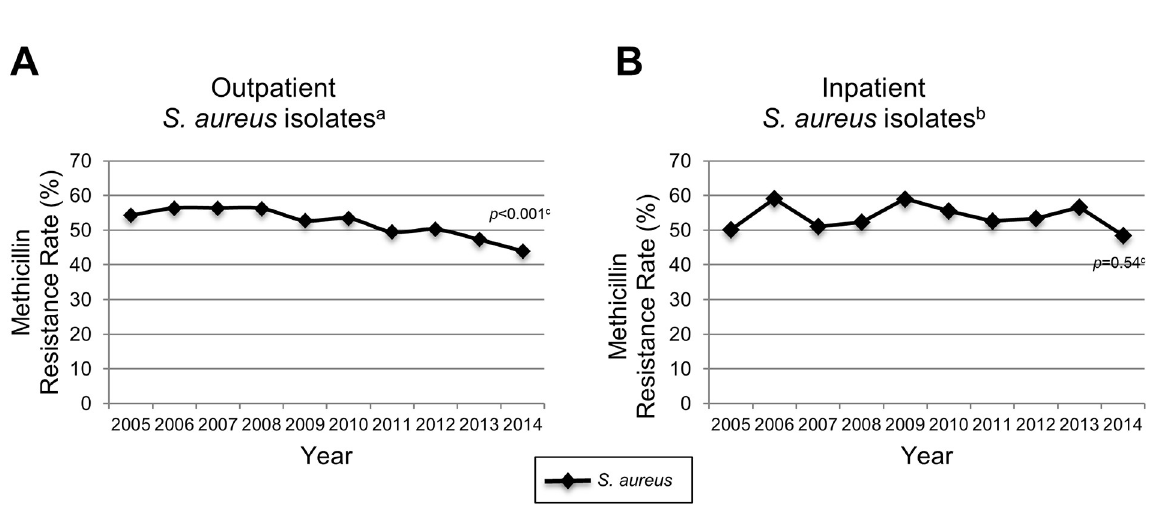
Fig 1. Methicillin resistance by year (2005–2014) in outpatient (A) and inpatient (B) S . aureus isolates from NCH. NCH indicates Nationwide Children’s Hospital. a Number of outpatient S . aureus isolates (n = 31,760). b Number of inpatient S . aureus isolates (n = 7,760). c p - value determined using the χ 2 test for